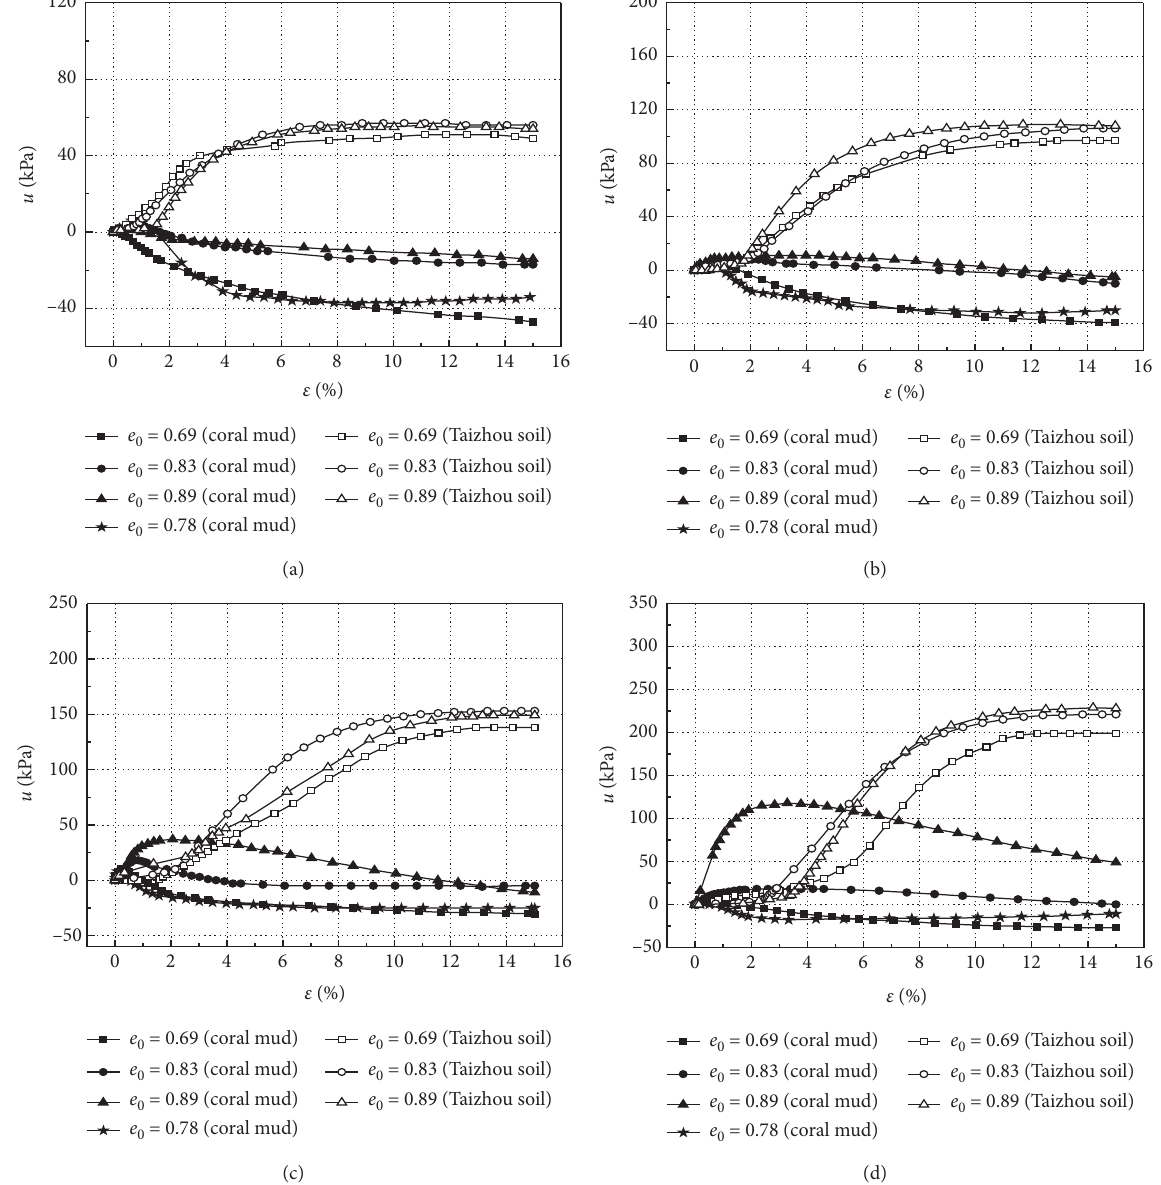
Figure 9: Pore pressures with different initial void ratios: (a) 100kPa, (b) 200 kPa, (c) 300kPa, and (d)